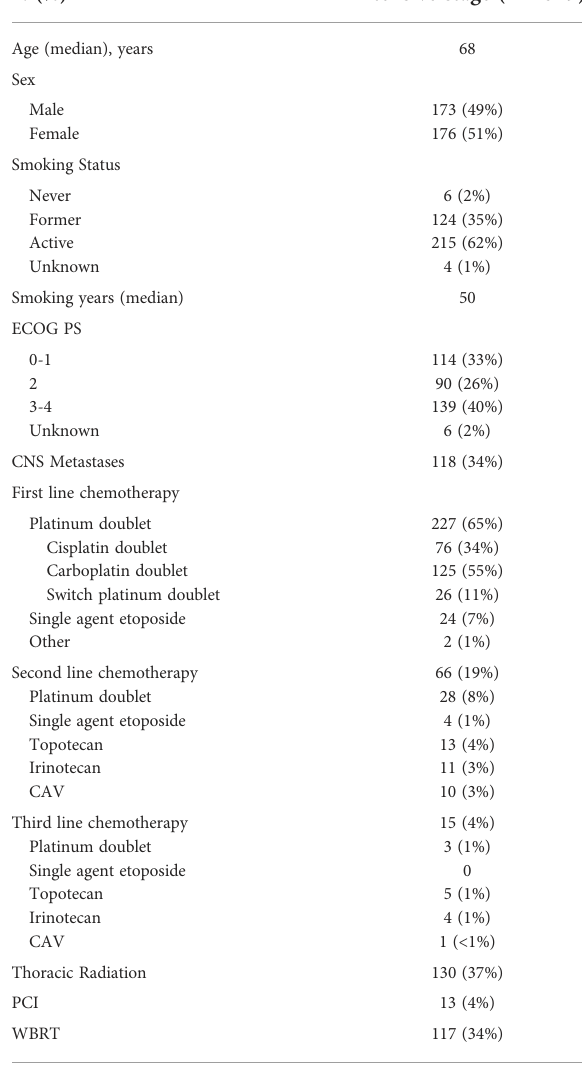
TABLE 1 Baseline characteristics and treatment history of extensive stage small cell lung cancer